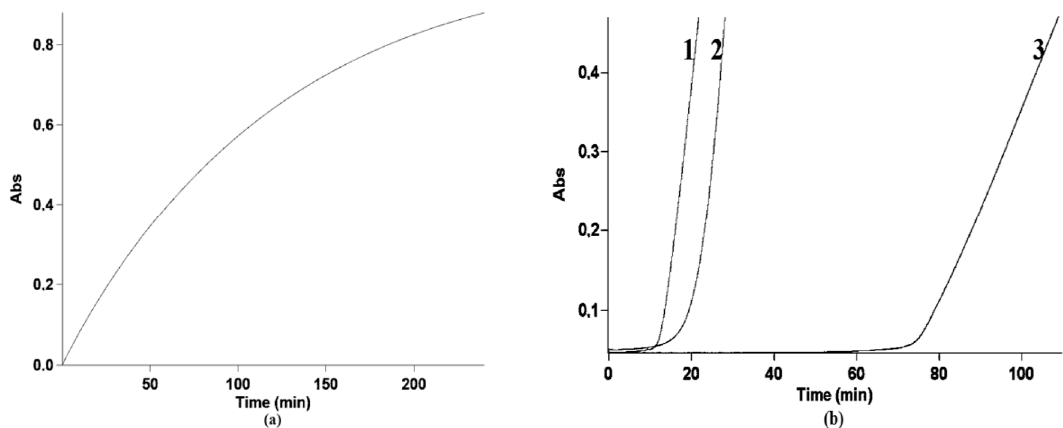
Figure 2. The averaged kinetic curves of the 2,2 (cid:48) -azino-bis(3-ethylbenzothiazoline-6-sulfonic acid radical (ABTS • + ) accumulation: ( a ) Without antioxidants or ( b ) in the presence of taxifolin (1) and glutathione (2), and their combination at a ratio of 1:8 (3). ( a ) Averaged from seven runs at the initial concentrations of ABTS and PP of 1.21 mM and 0.43 mM, respectively; λ 730 nm, pathlength 0.1 cm. ( b ) Taxifolin 20 µ M (1), glutathione 160 µ M (2), and their mixture at 20 + 160 µ M (3), respectively.